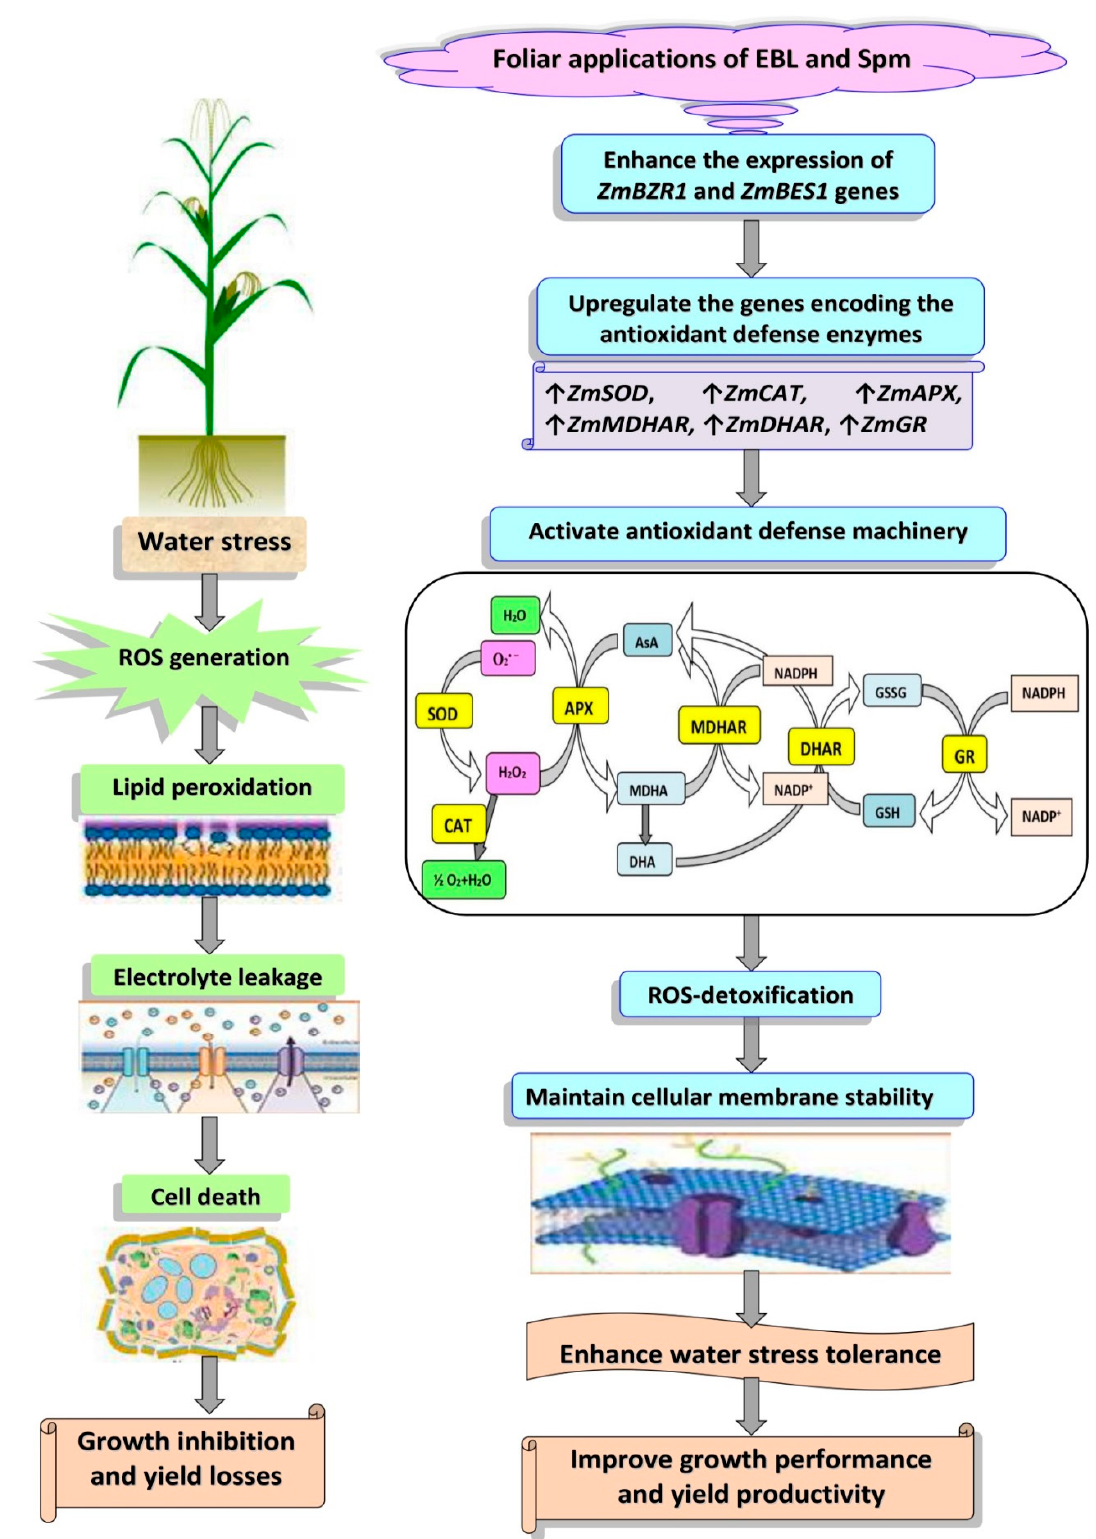
Figure 6. Foliar application of EBL and Spm alleviates water stress impact on maize growth and productivity by upregulating the genes encoding the antioxidant defense enzymes ( ZmSOD , ZmCAT , ZmAPX , ZmMDHAR , ZmDHAR, ZmGR) via signaling through the regulatory genes BZR1 and BES1 , which in turn improve the enzymatic and non-enzymatic antioxidant machineries, ROS detoxification, and cellular membrane stability.